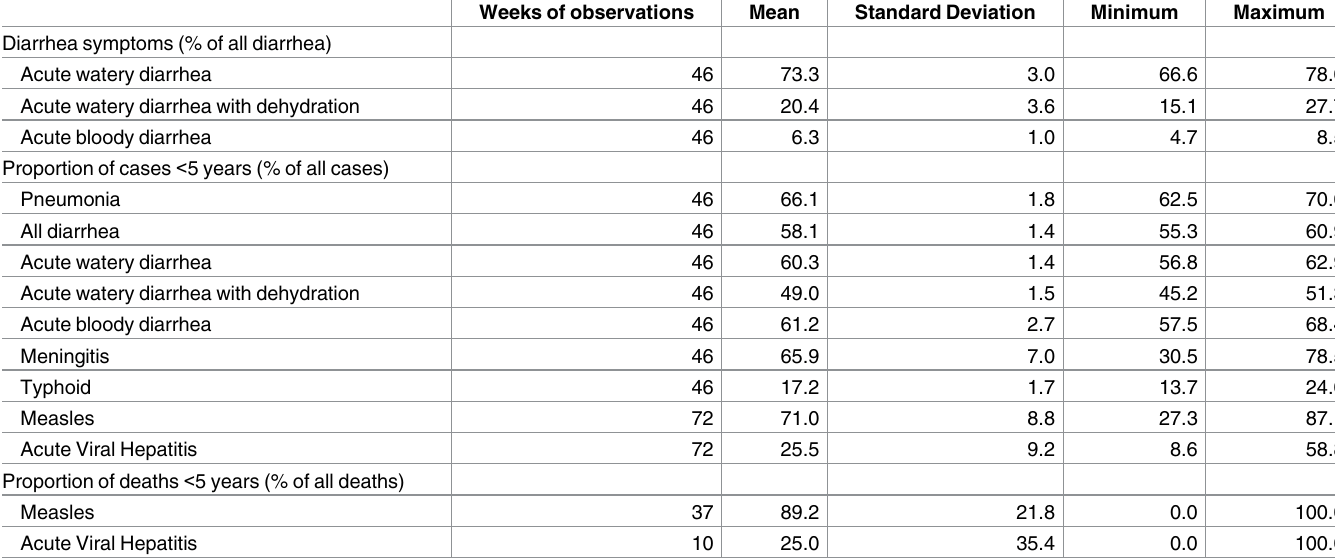
Table 1. Characteristics of suspected cases of six diseasesfrom Afghanistan’s DiseaseEarly Warning System, 2009–2015.